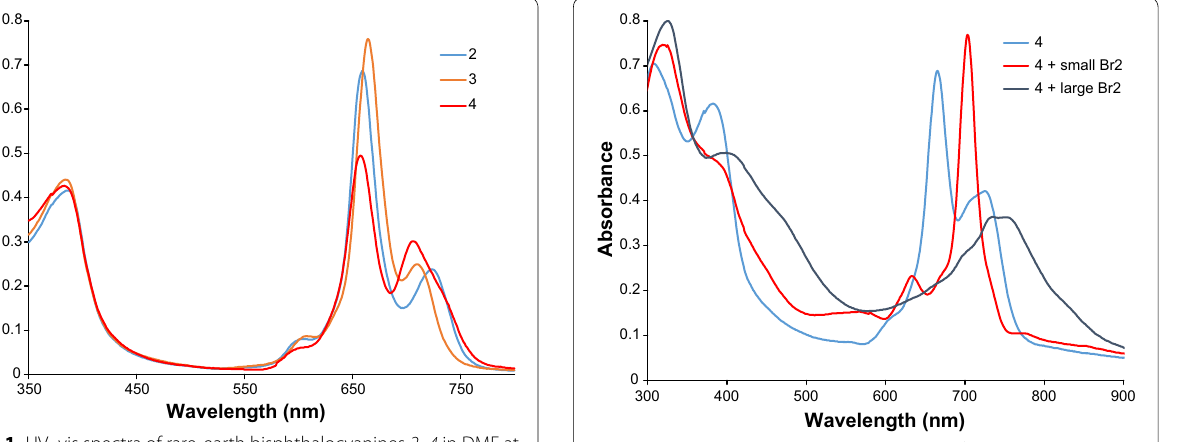
Fig. 3 UV–vis spectra of 4 in CHCl 3 at 20 mg l − 1 upon addition of various amounts of Br 2 . Red line addition of 10 μl 0.01 M Br 2 , black line addition of 20 μl 0.44 M Br